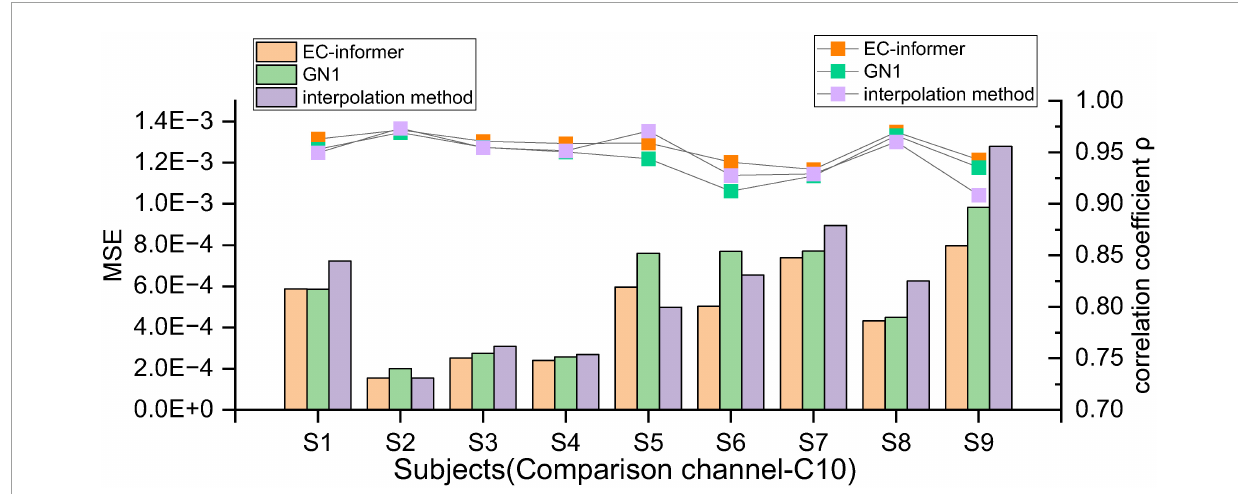
FIGURE6 The MSE and ρ of 9 subjects in the 10th channel were compared using EC-informer, GN1, and interpolation method. The results show that the complementary signals obtained using EC-informer have the best performance for most subjects.